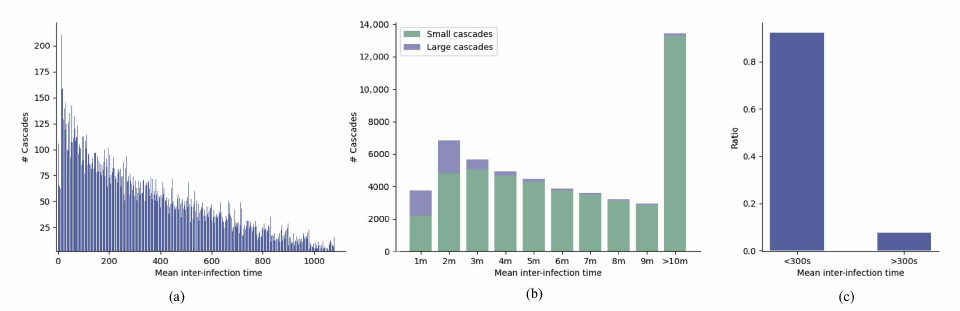
Figure 6. ( a ) Mean inter-infection time (seconds) and its corresponding number of cascades; ( b ) The distribution of large cascades over different mean inter-infection time (minutes); ( c ) More than 90% large cascades with a mean inter-infection time less than 300